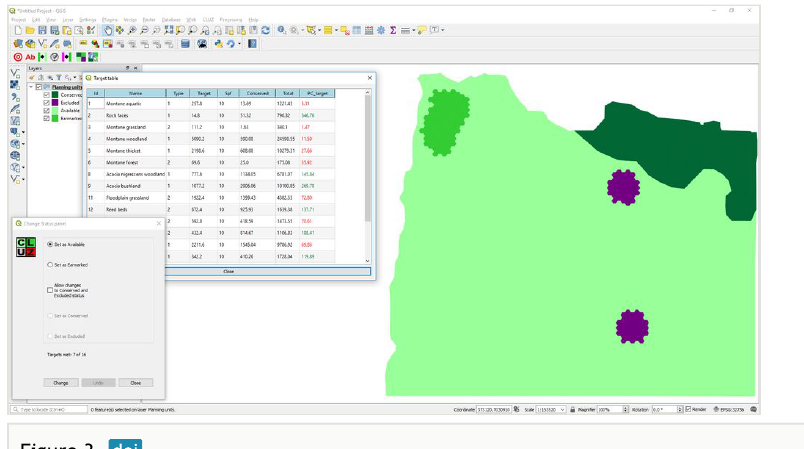
Figure 3. Screenshot of QGIS showing the planning units layer, CLUZ target table and Change Status panel. The Change Status Panel was used to change the status of the patch of planning units in the northwest of the planning region from Conserved to Earmarked. This updated the target table, which shows that adding this new patch to the protected area network would meet the target for rock faces and would contribute towards targets for another fi ve conservation features.